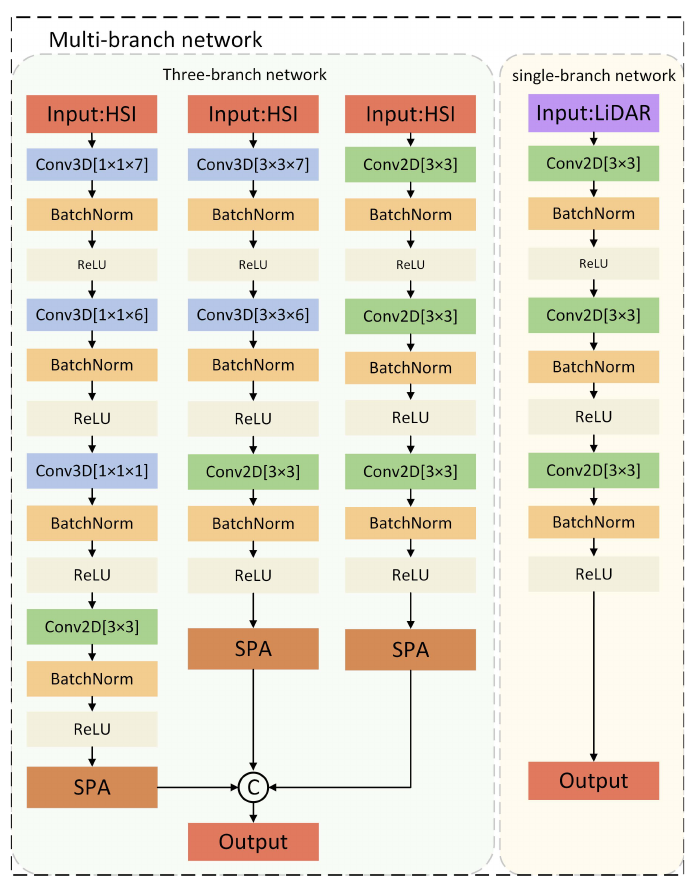
Figure 2. Overall parameter configuration of the designed feature extraction